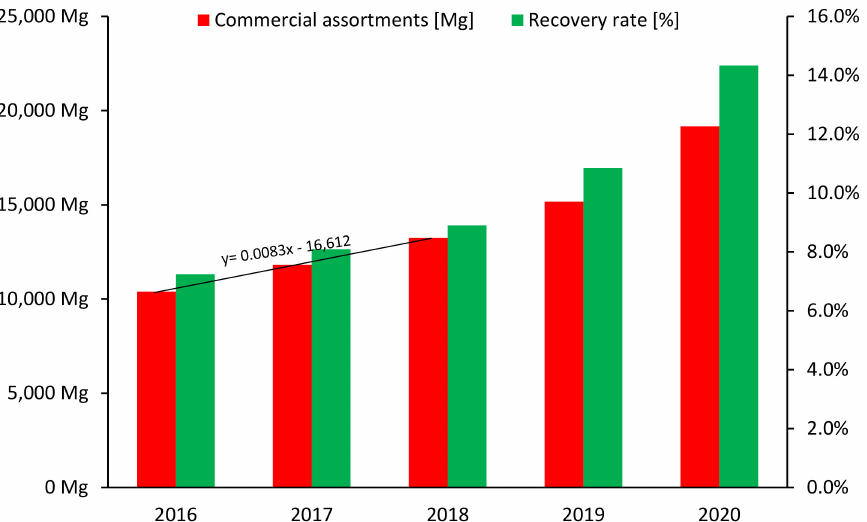
Figure 12. Change in the weight and the degree of recovery of commercial assortments obtained from municipal waste in 2016–2020 in the Municipal Waste Management Plant in Olsztyn,